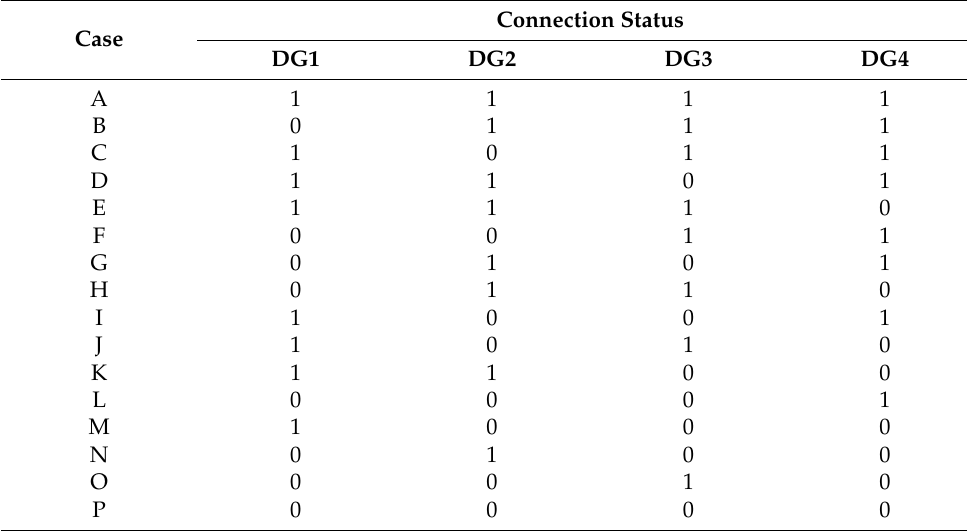
Table 1. Case studies involving the connection status of DG units.